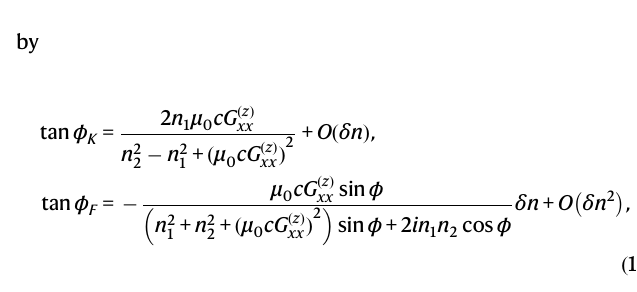
polarization plane while its imaginary part measures the circular dichroism, i.e., the intensity imbalance between the re fl ected left and right circularly polarized light. The Kerr angle is O ð μ but it can be much enhanced when n 1 ≈ n 2 because of the suppression of r xx .